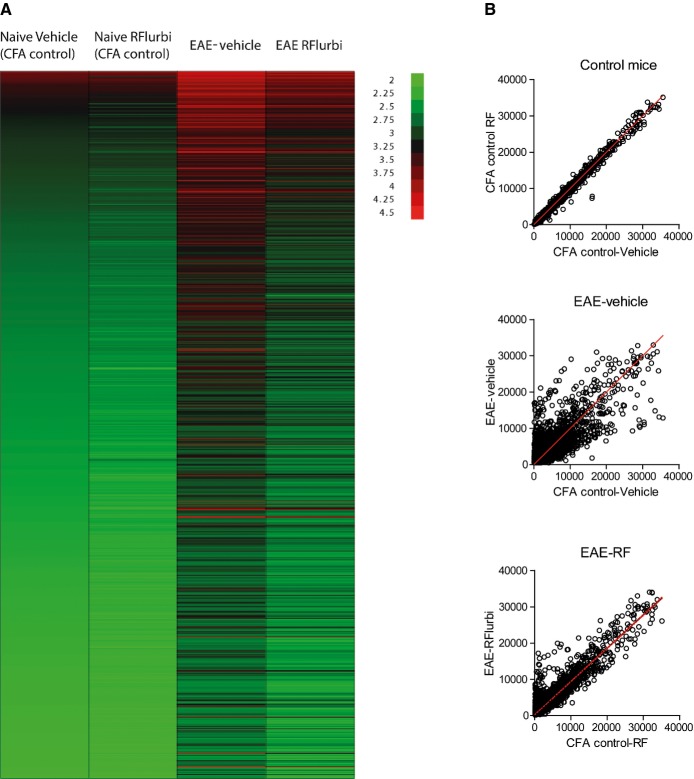
Reduction of EAE-evoked upregulation of pro-inflammatory genes in the spinal cord by R-flurbiprofenMicroarray mRNA analysis of the lumbar spinal cord in EAE and sham control mice treated with vehicle or R-flurbiprofen (10 mg/kg/day, drinking water) from the 5th day after immunization. Spinal cords were dissected out during the flare, day 16. Sham control mice were injected with CFA without MOG35-55. Three samples were analyzed per group, and each sample was comprised of pooled tissue from 3 mice, that is, the array data are based on n = 9 mice per group. Top 100 regulated genes in Supplementary Table S8.Heat map of log transformed mRNA expression of genes, which were upregulated ≥ twofold in the EAE-vehicle group (green low intensity, red high intensity).Scatter plots of mRNA intensities. CFA control mice (no EAE) treated with vehicle or R-flurbiprofen (top), vehicle treated CFA control mice versus vehicle treated EAE mice (middle) and R-flurbiprofen treated CFA control mice versus R-flurbiprofen treated EAE mice (bottom).